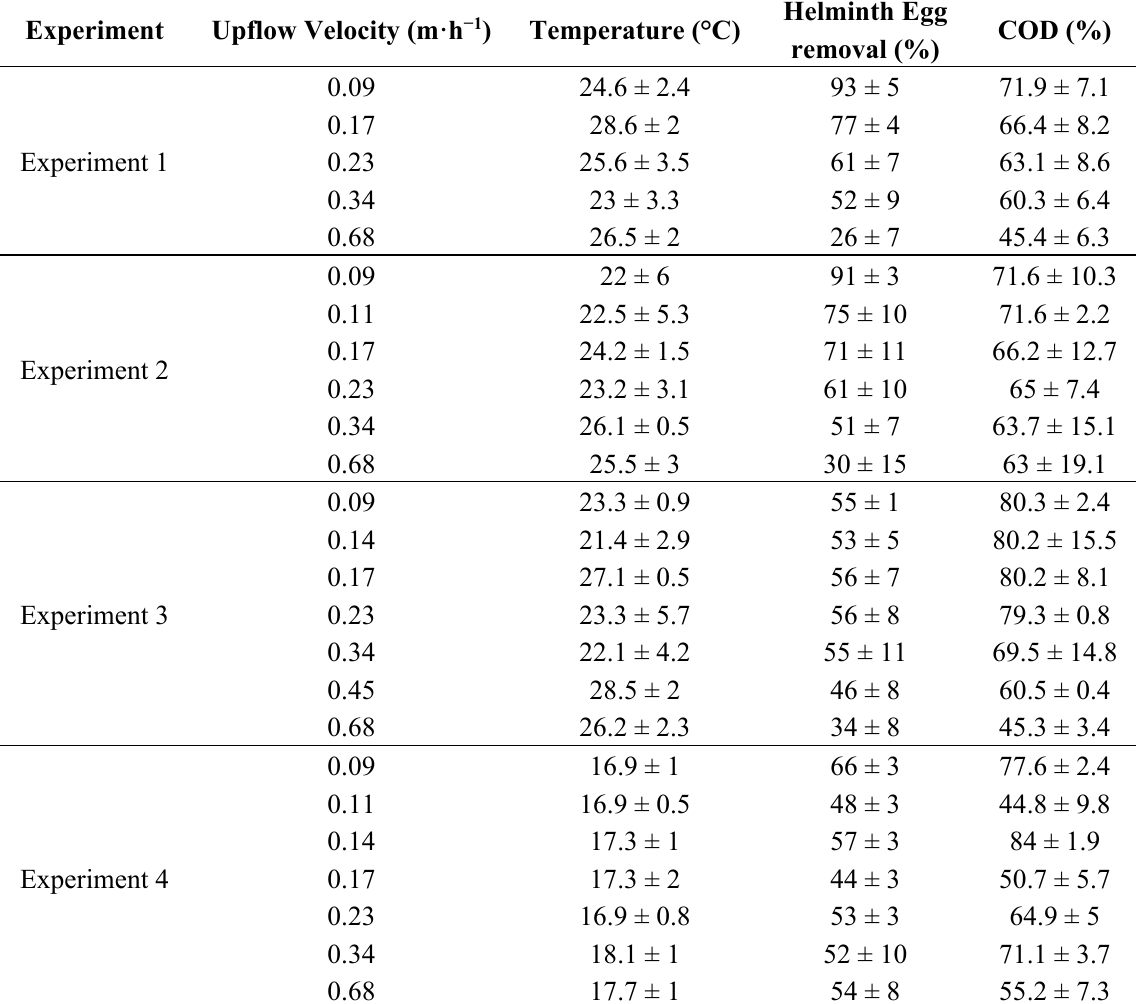
Table 3. Results of helminth egg removal and chemical oxygen demand (COD) removal efficiencies at applied upflow velocities and wastewater temperatures. Each upflow velocity was applied three times in each UASB reactor. Then a total of six samples per upflow velocity was